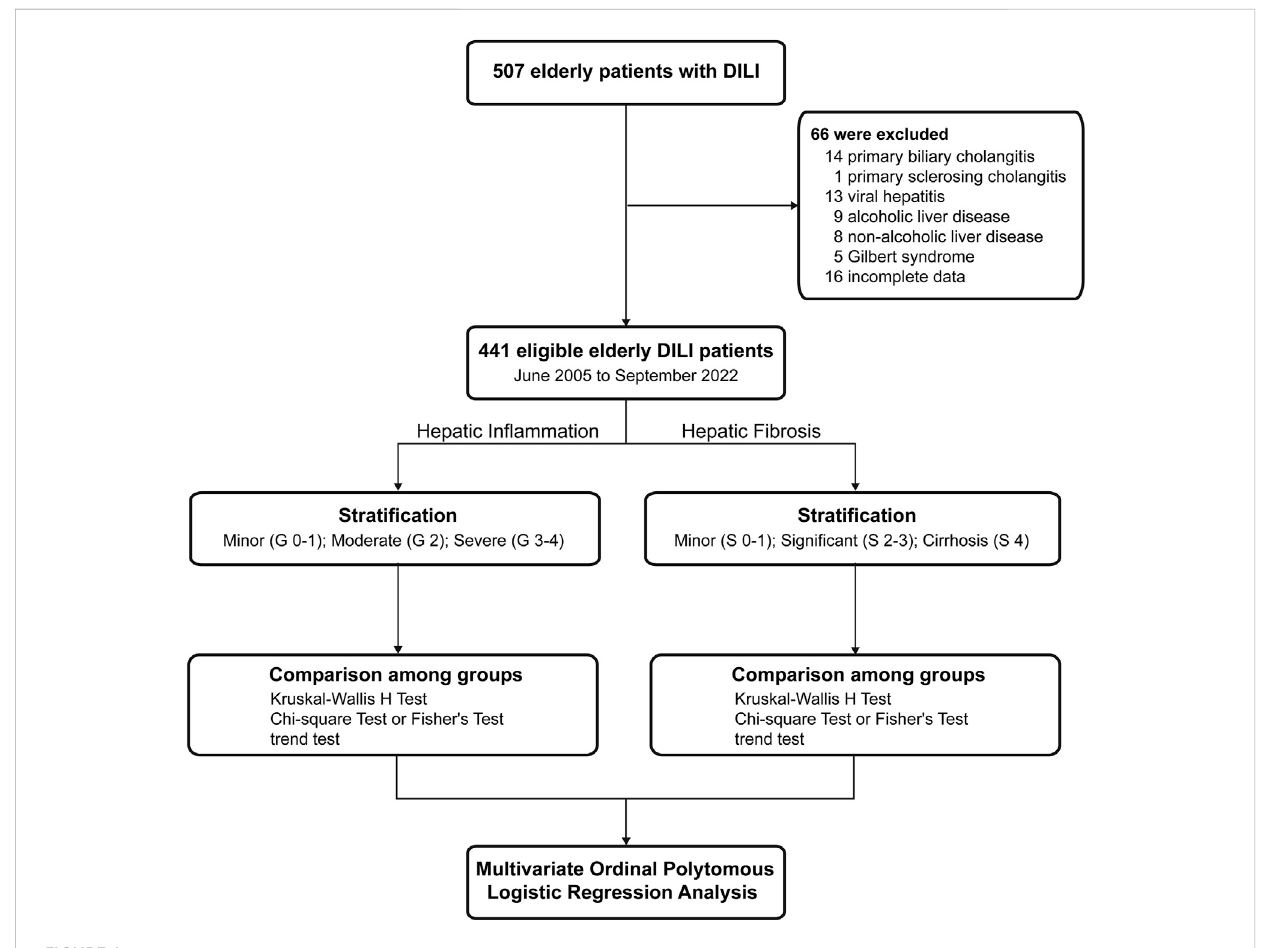
FIGURE 1 Flow chart of study population. DILI, drug-induced liver